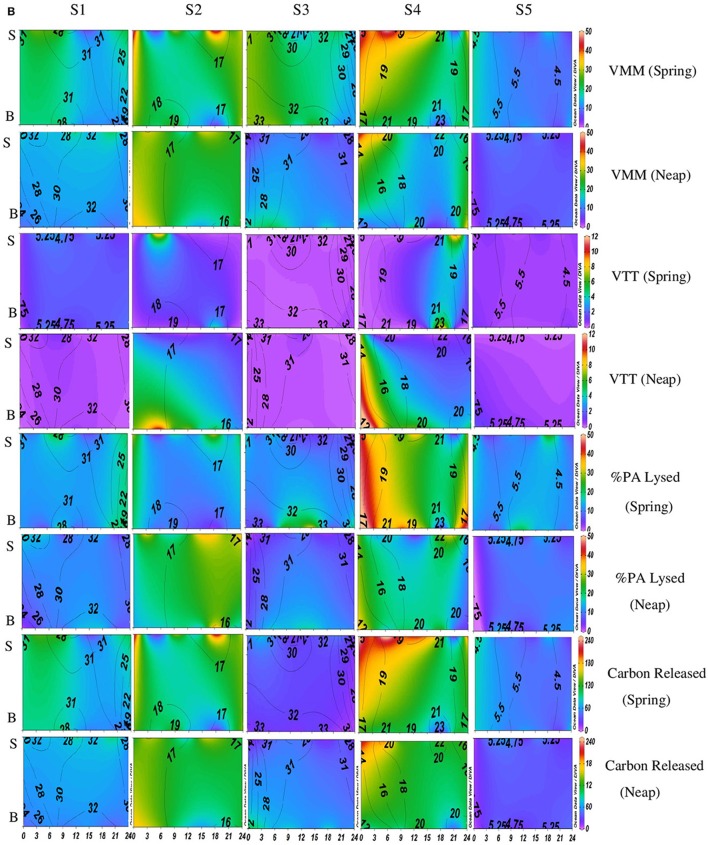
Temporal variations (diel and tidal) in biological parameters during pre-monsoon (PRM) in CE. X-axis represents the time series observations from 00:00 to 24:00 h and Y-axis represent the vertical section of the water column (S, Surface; B, Bottom). Z-axis represent different parameters in color contours and salinity is superimposed as the line contours. The vertical panels S1, S2, S3, S4, and S5 represents the five stations. The horizontal panels represent various parameters during PRM, such as, Viral-mediated mortality (VMM%), Viral turnover time (VTT) (d−1), % of BA lysed, and Carbon released (μg/C/L/day) during spring and neap phases separately.